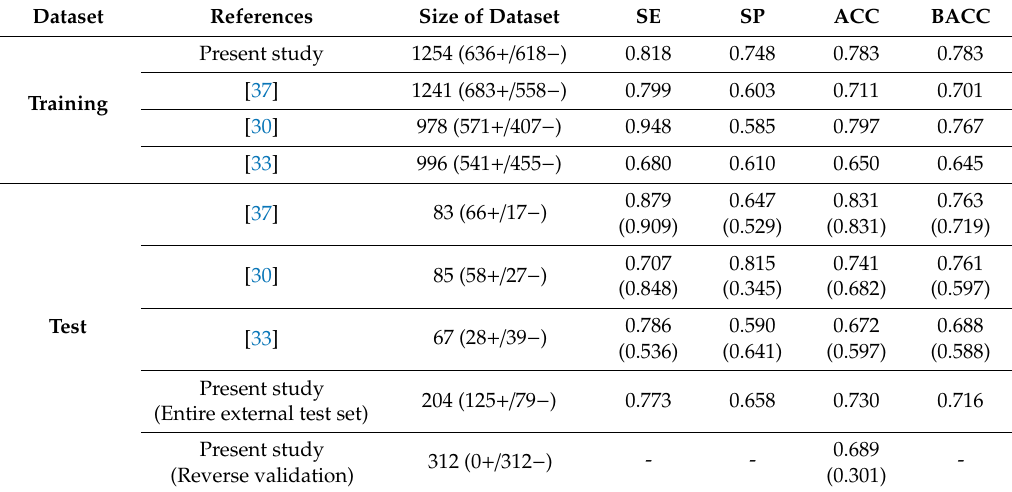
Table 2. Comparison between our model and prior